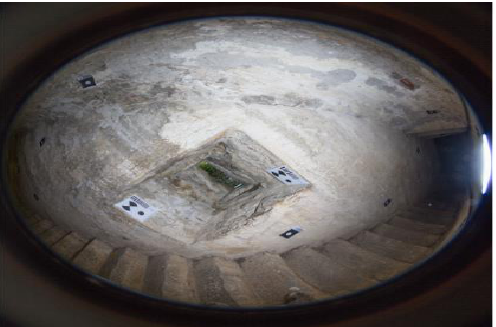
Figure 3: Side capture of the wall in the corridor of the Castle